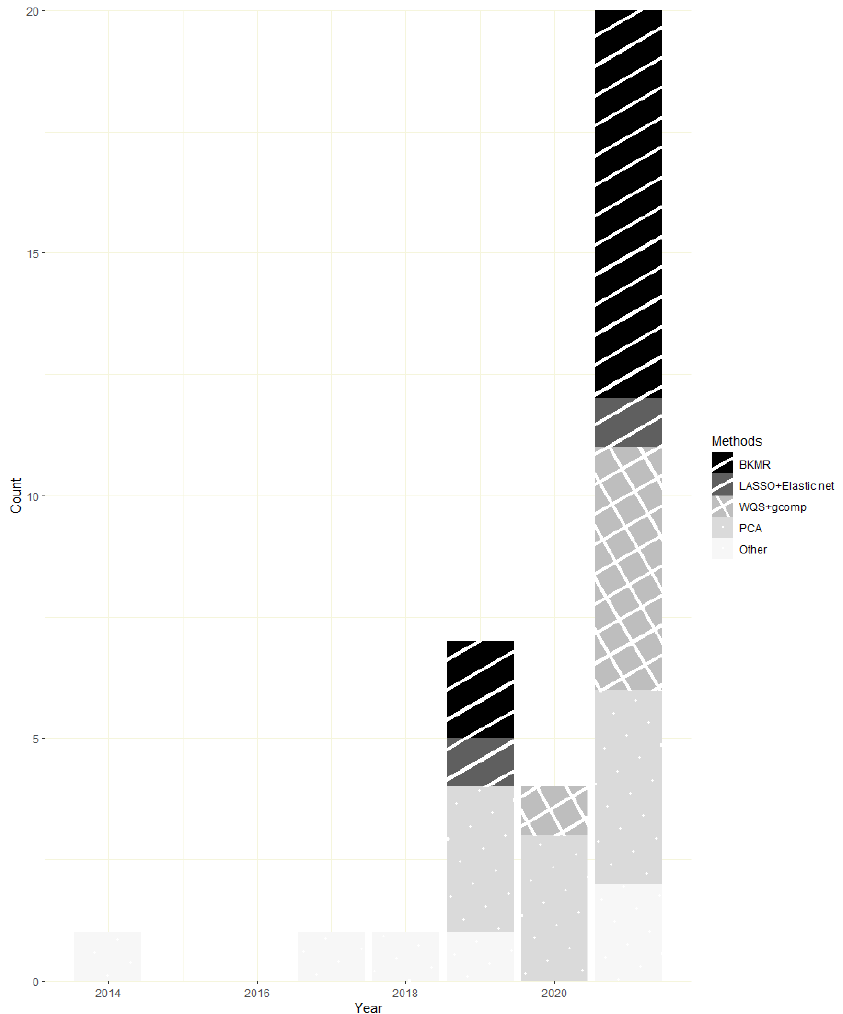
Figure 2. Number of included studies published by year and multi-pollutant approach. Note: Some studies included multiple cardiovascular disease (CVD) related outcomes or mixture analysis methods.